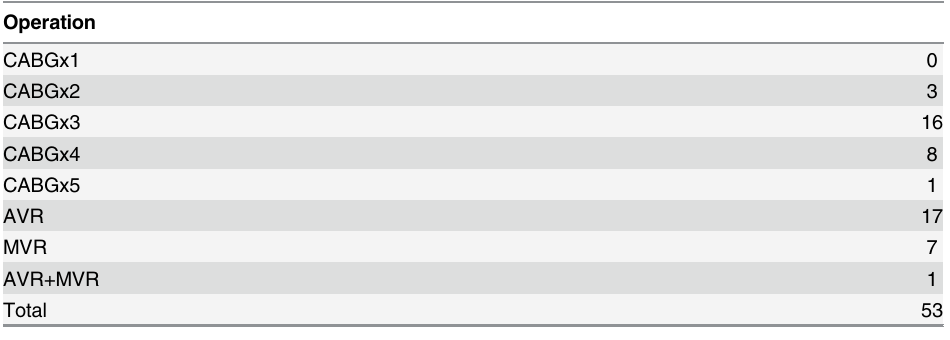
Table 2. Types of surgery